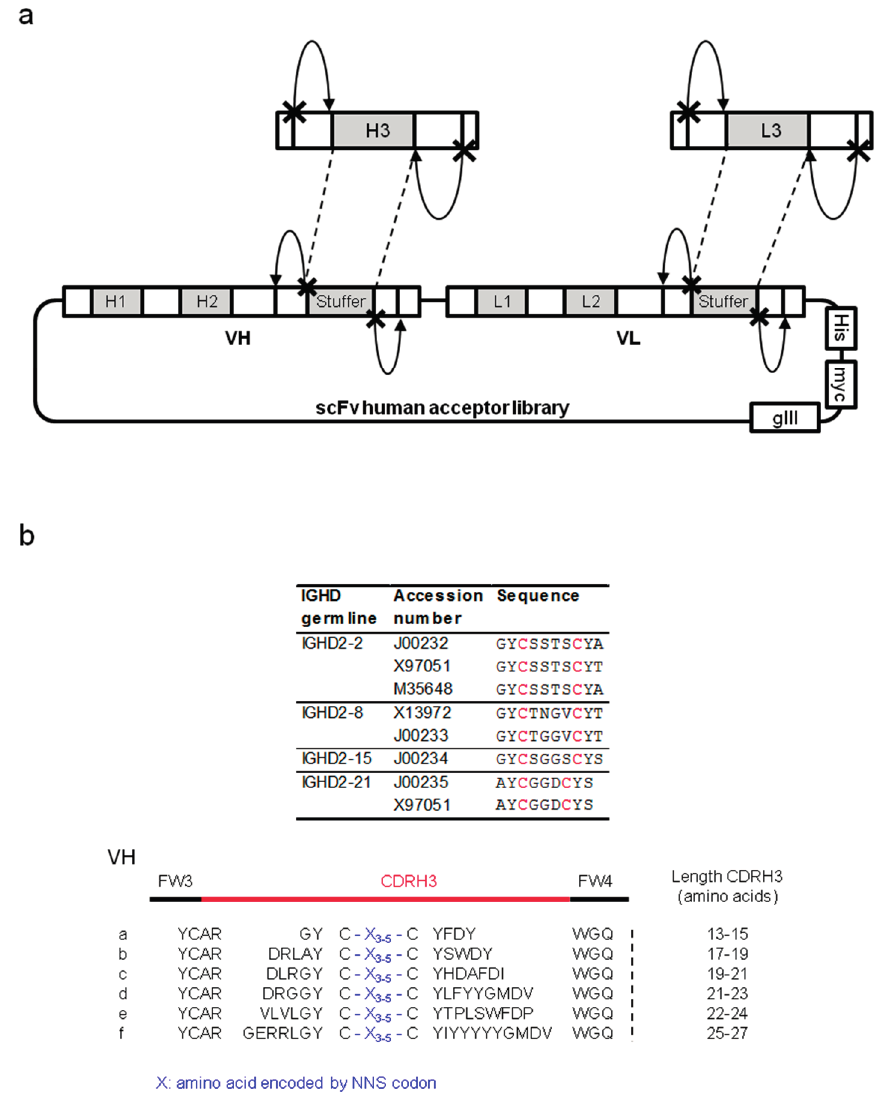
Figure 1. Long CDRH3-biased library for the inhibition of cryptic sites. ( a ) Schematic representation of library construction using type IIS restriction enzymes. The site of restriction recognized by the type IIS enzyme is symbolized by a cross and the cleavage activity of the enzyme by an arrow. ( b ) Design of the long CDRH3 repertoire. The alignment of amino acid sequences corresponding to human D segments that include two cysteines (IMGT database) and their corresponding GenBank accession numbers are shown (top panel). The six motifs covering lengths between 13 and 27 amino acids (a–f), incorporating three, four or five randomized positions between two cysteines, are